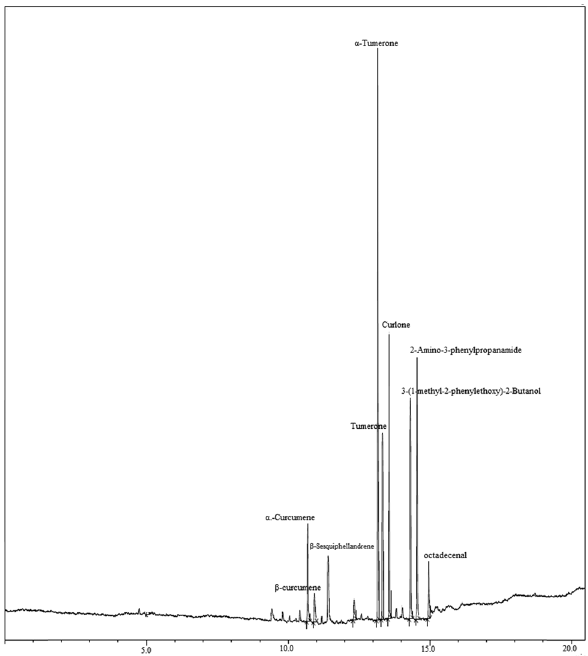
Figure 3: GC - MS pro fi le for PE extract of Curcuma longa rhizome.